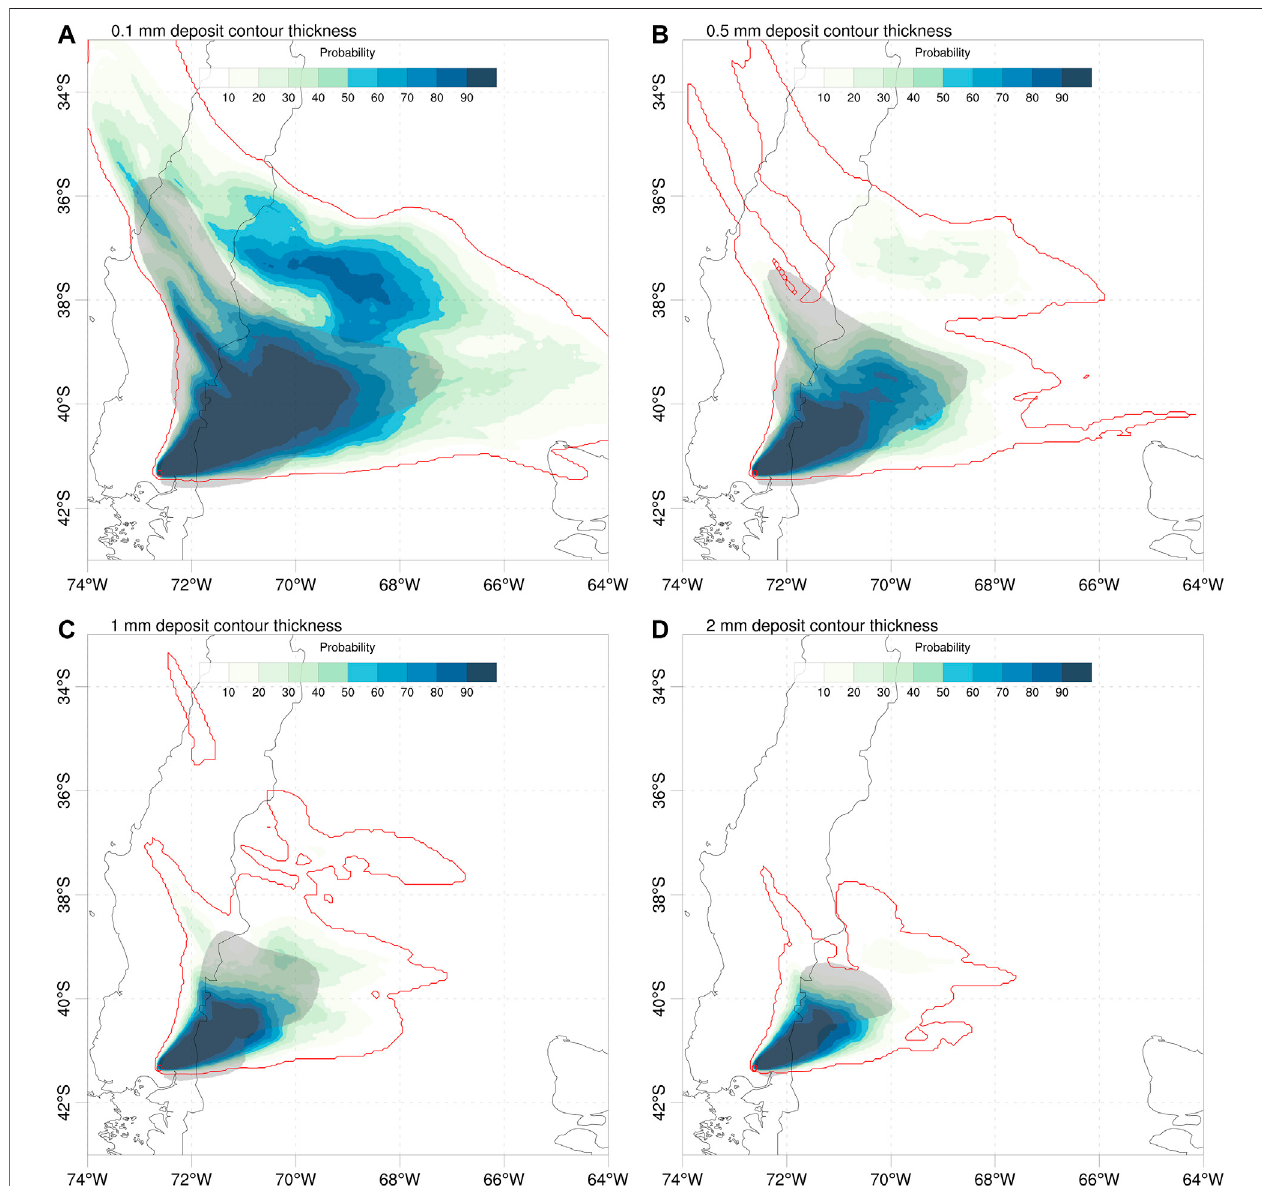
FIGURE 8 | Validation of Calbuco probabilistic forecasts with deposit isopach contours. Color contours give the model probability (in % ) for deposit thickness to exceed 0.1,0.5, 1,and2 mm. Grey- fi lledareas showthecorresponding isopachsestimated byRomeroetal.(2016) fromextrapolation ofdepositpointmeasurements. The outer red contour indicates the 1.56% (1/64) probability. Red circle shows the location of Calbuco volcano. The resulting values of generalised categorical metrics and Brier Score (BS) are reported in Table 7 .